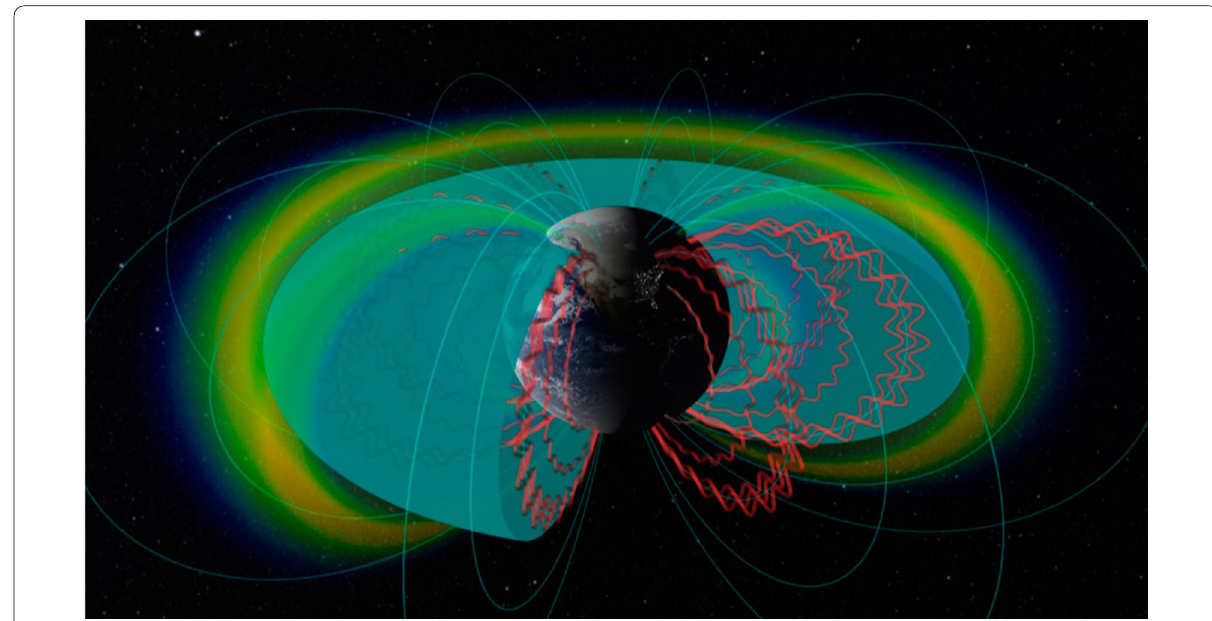
Fig. 8 Schematic diagram illustrating the inner part of Earth’s magnetosphere. The outer edge of the VLF “bubble” is sketched showing intense waves confined inside this boundary (Courtesy of